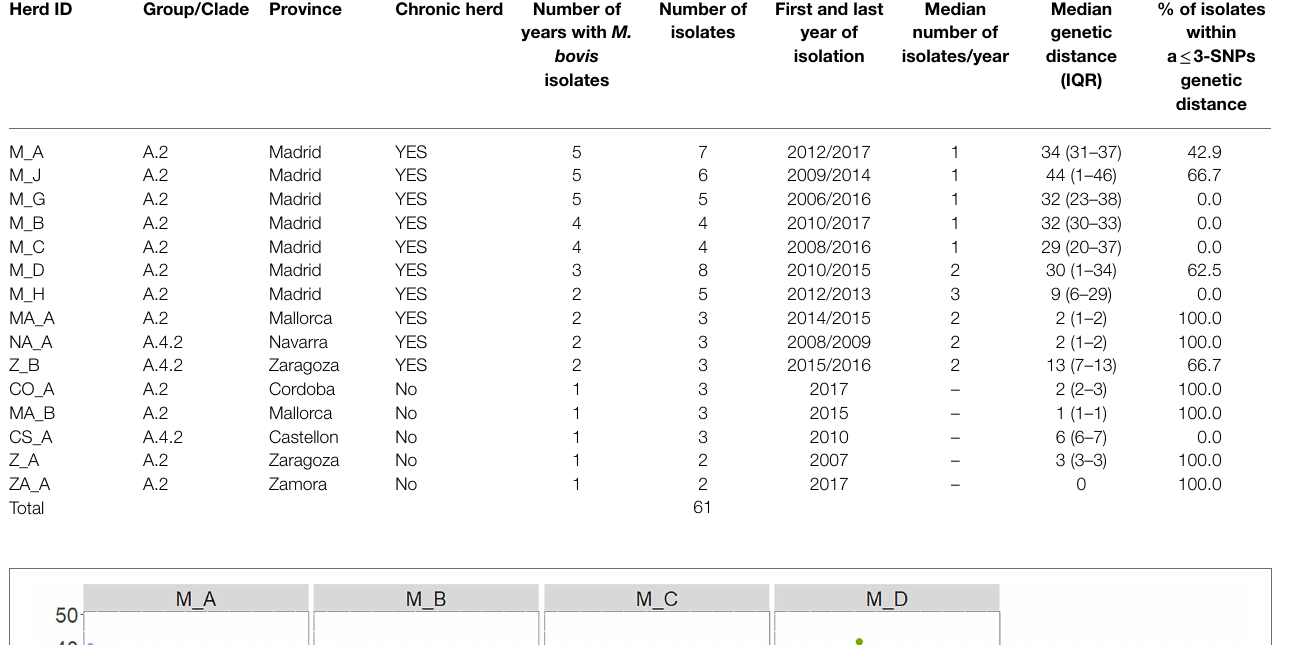
TABLE 2 | Herd identification, province of origin, number of isolates, years between first and last isolations, median number of isolates recovered per year, and % of isolates within a ≤ 3-SNPs genetic distance in herds included in the analysis of within-herd Mycobacterium bovis genetic diversity. Herd ID Group/Clade